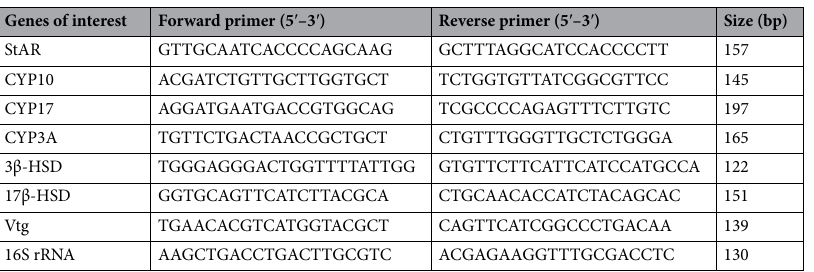
(http://www.ebi.ac.uk/Tools /msa/muscl e/) 29 and CLC Main Workbench Version 7.7. Prediction of conserved protein domains were performed by NCBI conserved domain database 30 and InterPro (https ://www.ebi.ac.uk/ inter pro) 31 . Protein precursors were analyzed for their evolutionary relationship with other known orthologous proteins, and illustrated by phylogenetic trees using the MEGA5 program using Neighbor-joining estimation (1000 bootstraps) 32 . Illustrations were indicated by the genus and species name. Tissue collection and total RNA extraction. Mature male (n = 10) and female (n = 10) sea cucumbers H. scabra were obtained from Ko Libong, Trang Province, Thailand, with an average weight of 100–150 g. They were then anesthetized by immersion in ice-cold seawater for 30 min before sacrifice. The various tissue samples including CNR, RNC, gonads (testes and ovaries), respiratory tree, longitudinal muscle, intestine, and body wall were collected and immediately frozen in liquid nitrogen and then kept at – 80 °C until preparation of total RNA. Frozen tissues were individually homogenized and the total RNA was extracted using the TRIzol reagent (Thermo Fisher Scientific, MA, USA), following the manufacturer’s protocol in combination with a DNase I (Thermo Fisher Scientific, MA, USA) treatment to eliminate potential genomic DNA contamination. The quan- tity and quality of RNA samples were measured using spectrophotometry (NanoDrop 1000; Thermo Fisher Scientific, DE, USA). Total RNA of each tissue was pooled and dried separately.